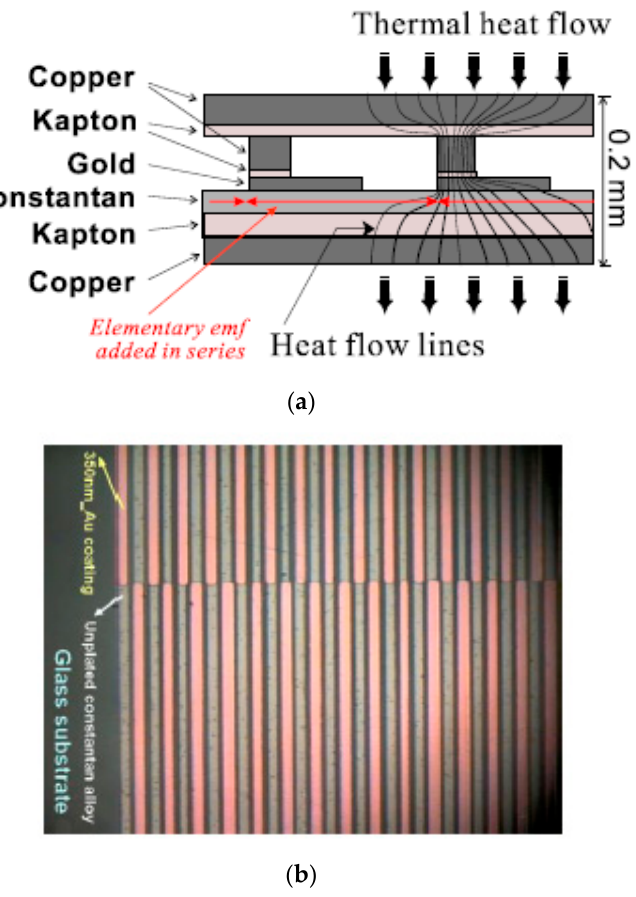
Figure 1. HFM fundamentals: ( a ) Cross section view of a generic structure; ( b ) Arrangement of a specific golden plated planar thermopile deposited on a glass substrate.